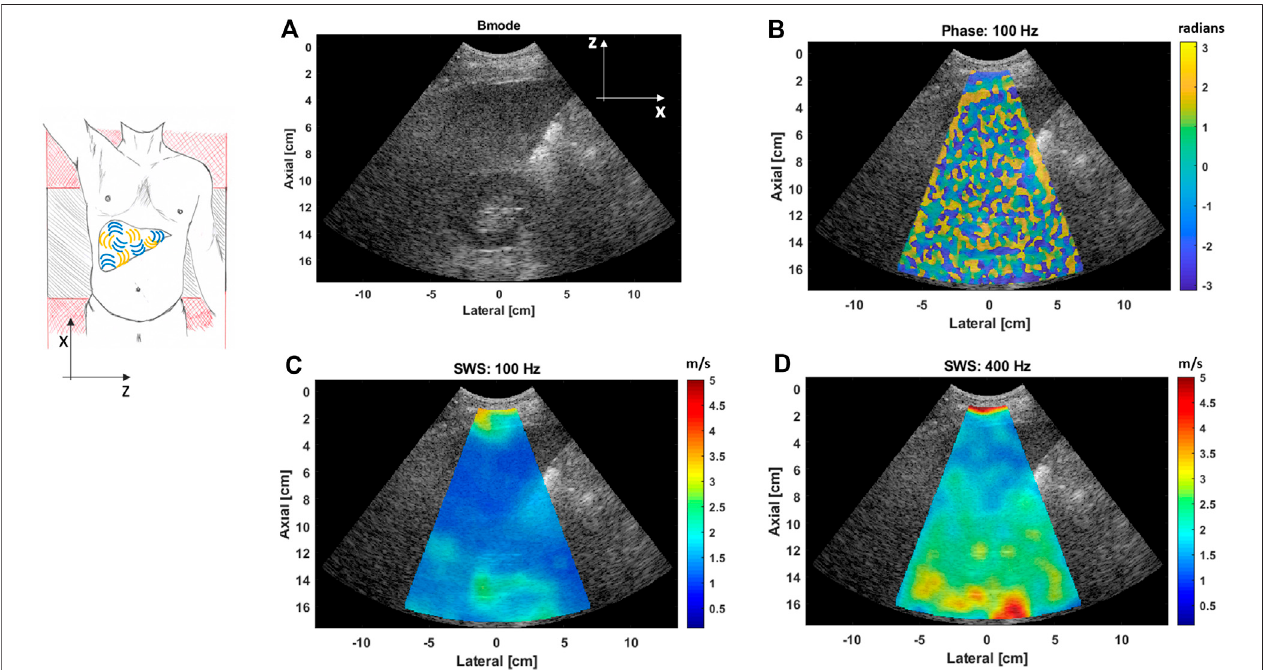
FIGURE 8 | (A) B-mode image showing the liver and kidney of an obese patient. (B) Extracted phase map pattern at 100 Hz, the random pattern indicates the different propagation directions of the shear waves generated with the vibration sources. (C,D) SWS images, superimposed on their corresponding B-mode images, obtained with the US-RSWE approach at two different vibration frequencies, 100 Hz (C) and 400 Hz (D) . It can be noted that better differentiation between the liver and kidney is obtained as higher frequencies are used.